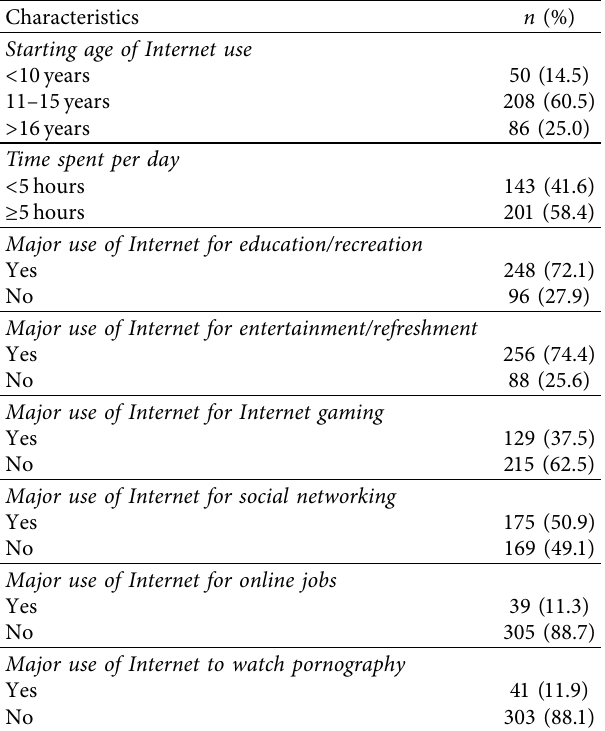
Table 2: Internet use